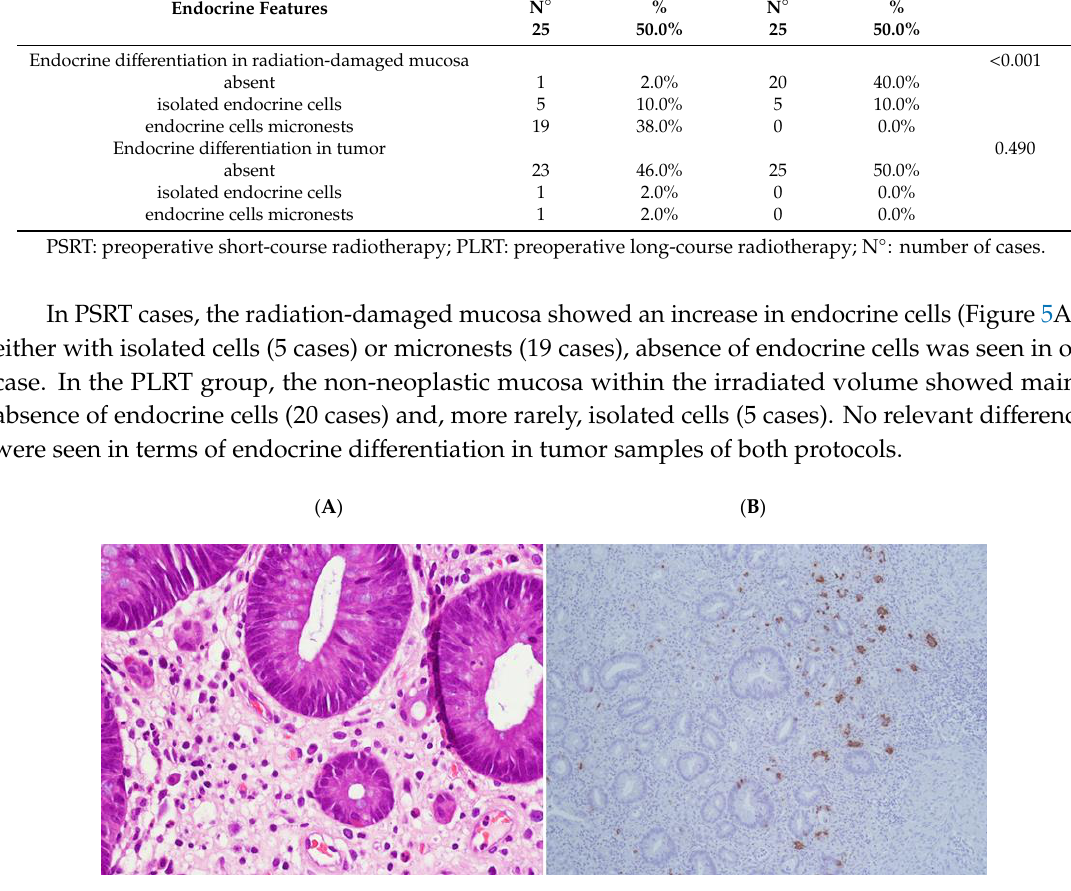
Table 2. Endocrine features in PSRT and PLRT cases.